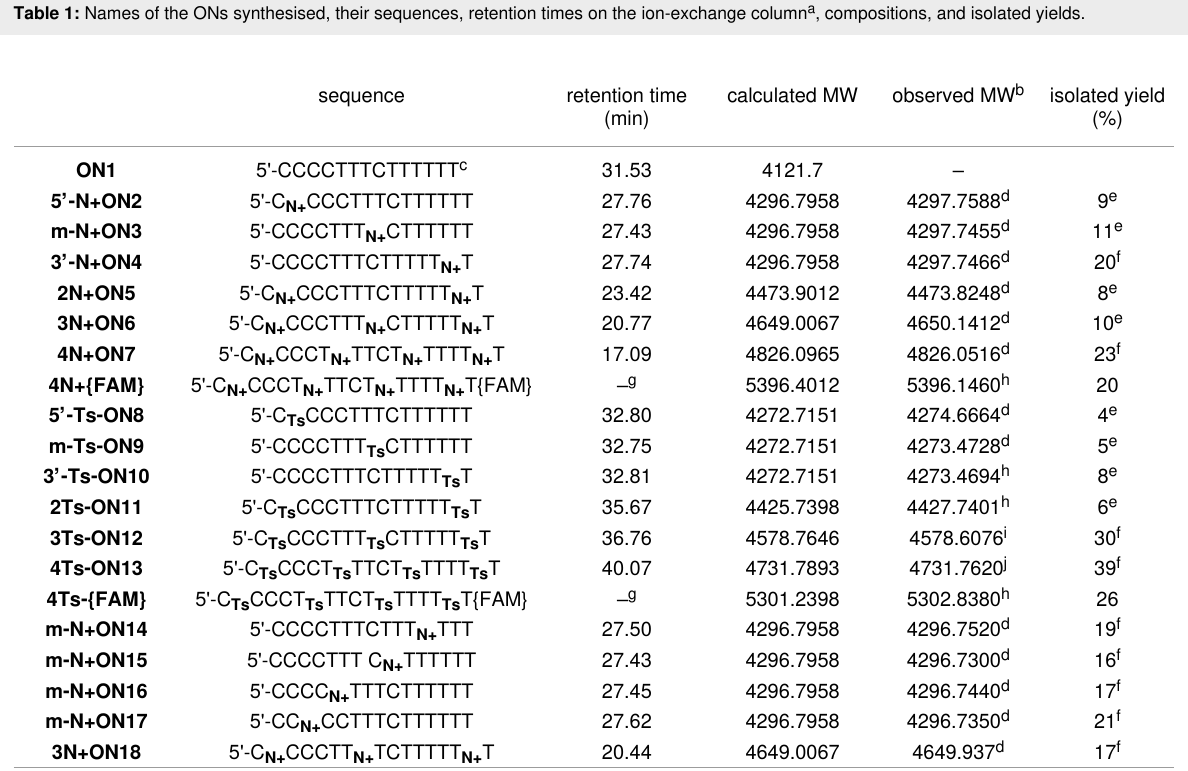
Table 1: Names of the ONs synthesised, their sequences, retention times on the ion-exchange column a , compositions, and isolated yields.